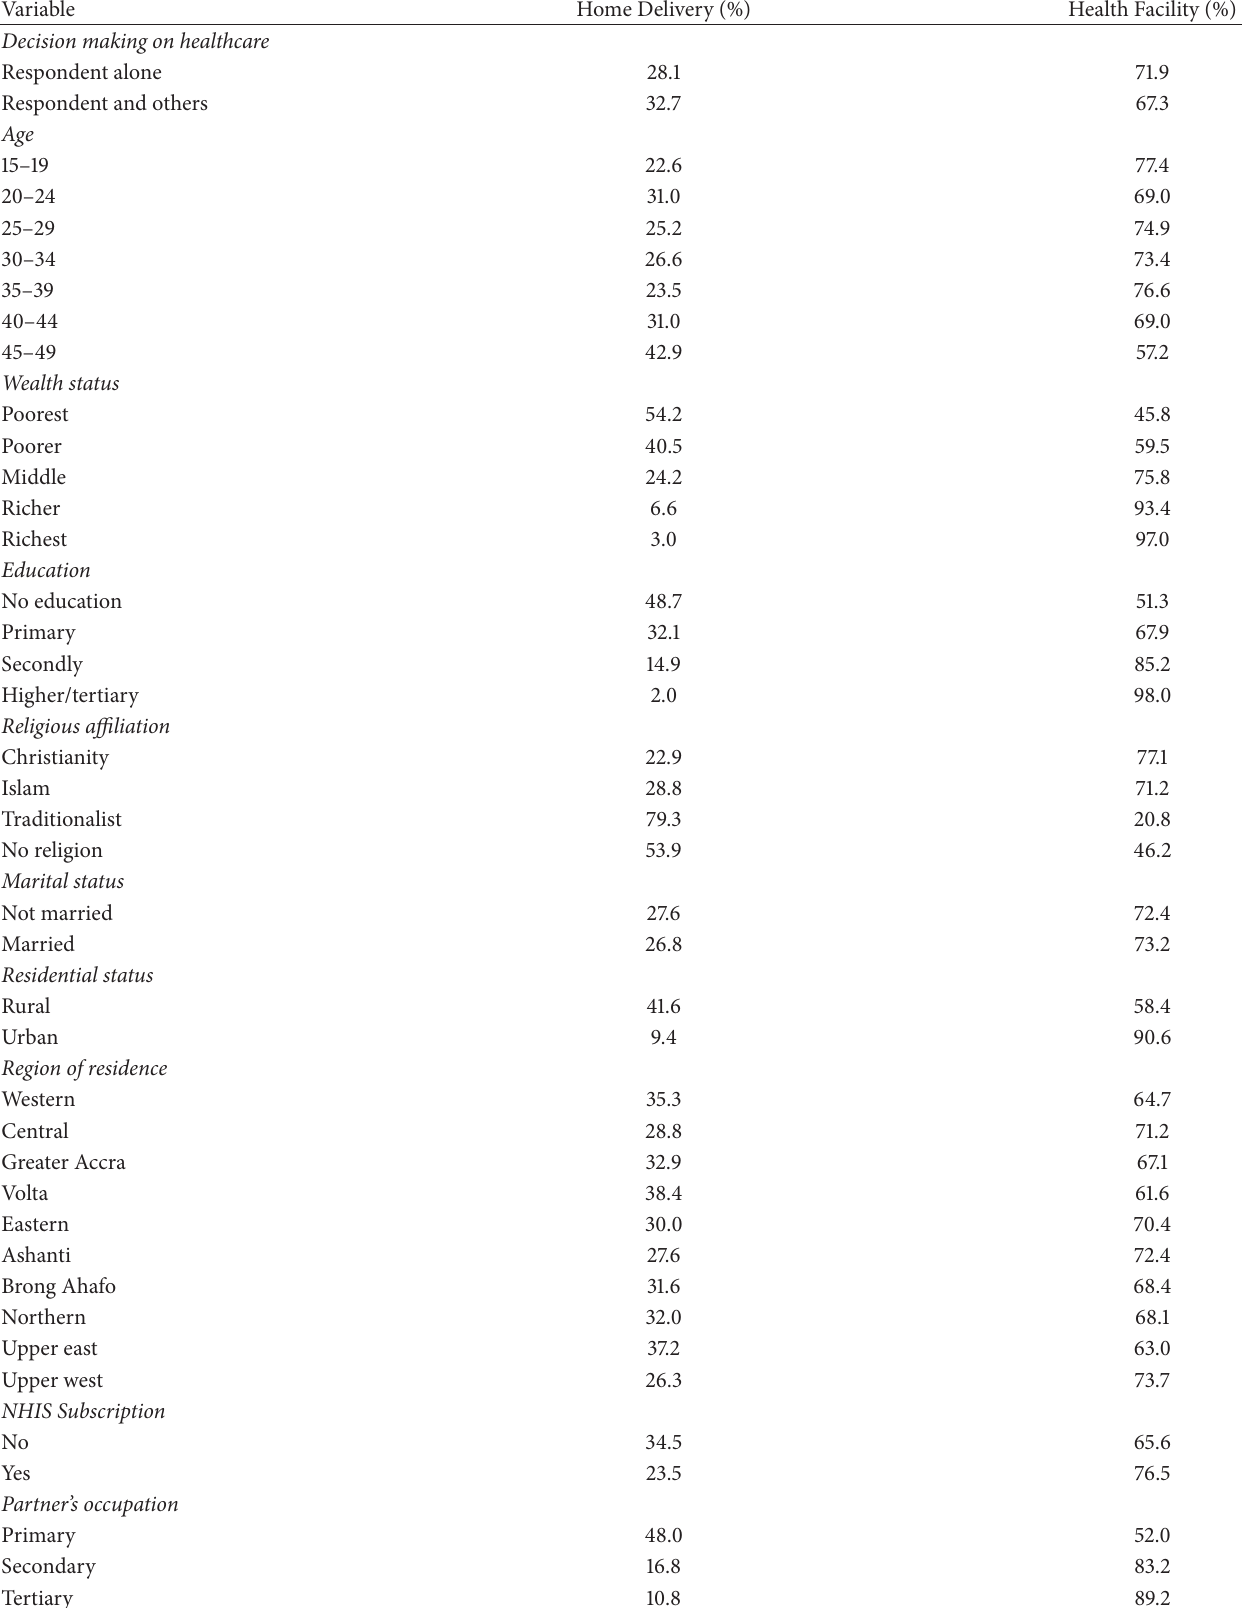
Table 3: Distribution of place of delivery by healthcare decision-making